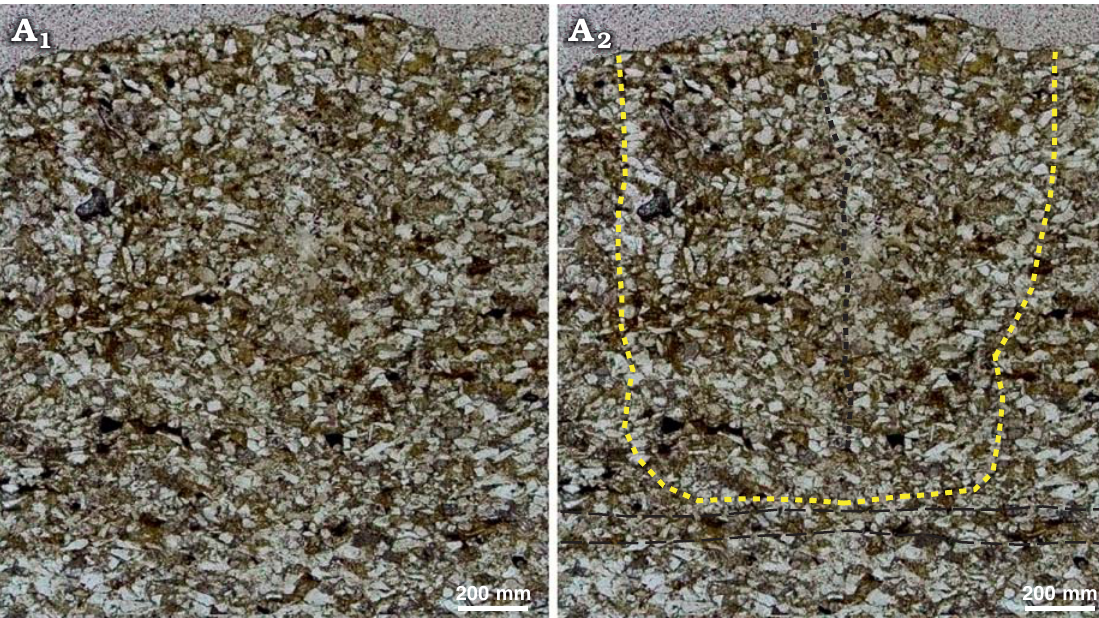
Fig. 5. Thin section of Gyrochorte comosa Heer, 1865 (NMB O156) from Mulichinco Formation, Lower Cretaceous, Puerto Curaco, Neuquén Province, Argentina. Original photomicrograph (A 1 ); photomicrograph with overlay (A 2 ); note displaced grains within the G. comosa in particular along its bound- aries (yellow doted line), central divide within trace (black doted line), faint, undeformed lamination of sediment horizontal black dashed lines. Photo in plain